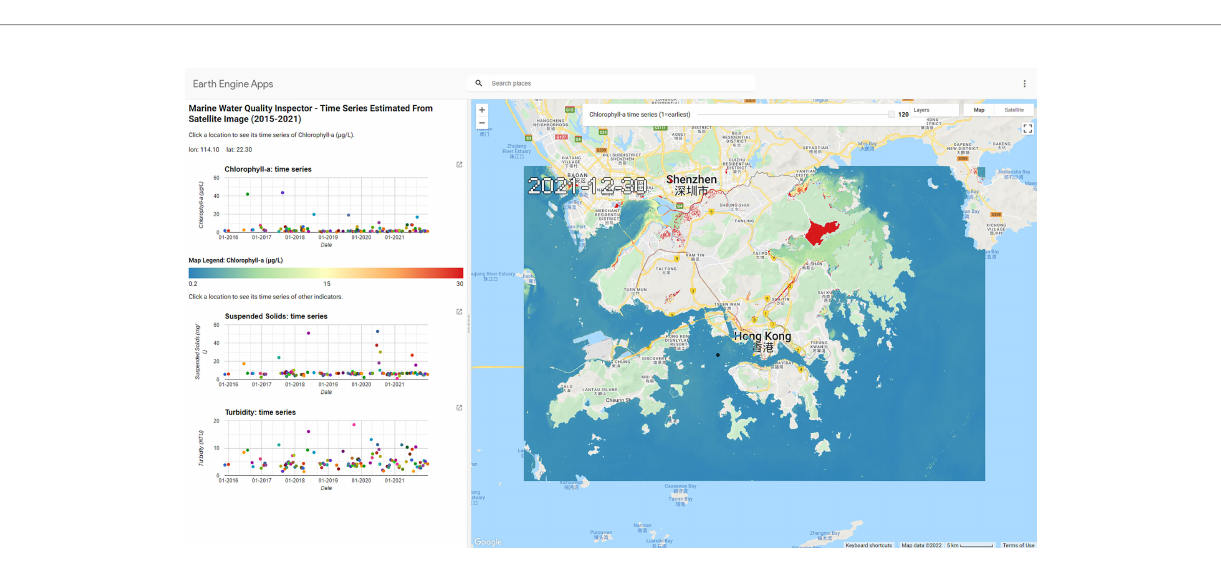
FIGURE 7 | A screenshot of the developed online application in Google Earth Engine showing the water quality map for a speci fi c date and time-series charts for a speci fi c